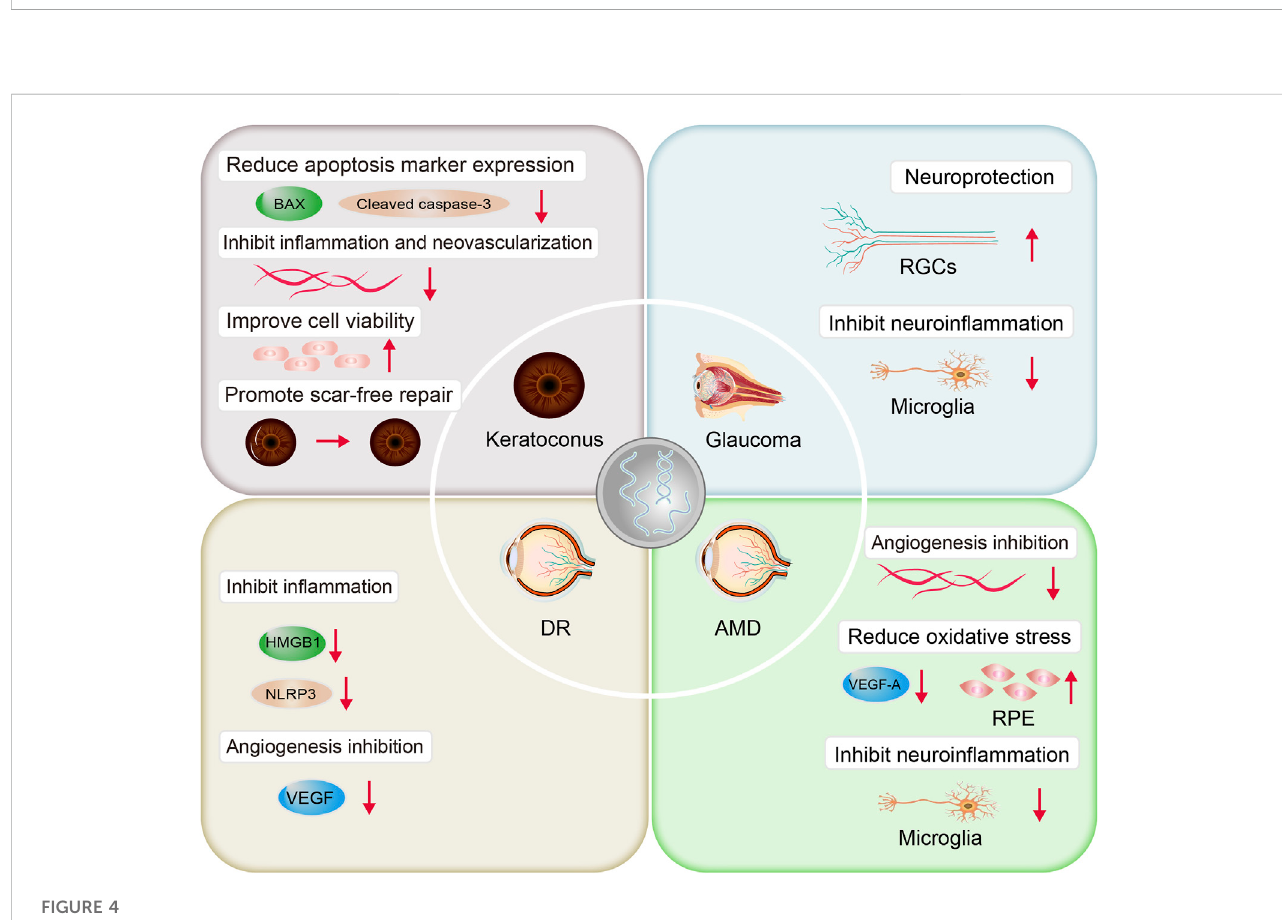
FIGURE 4 Mechanism of therapeutic action of exosomes in ocular